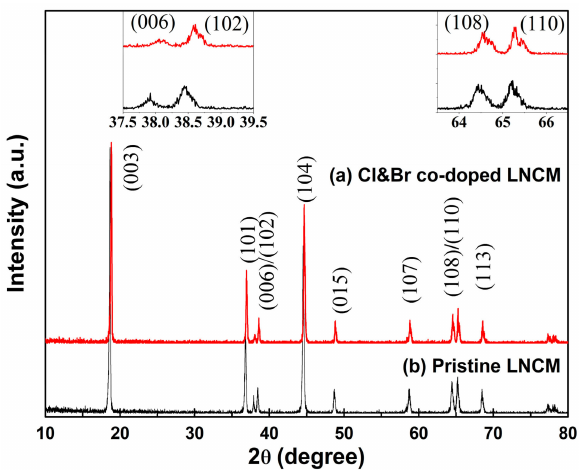
Figure 2. XRD patterns of the synthesized LiNi 1/3 Co 1/3 Mn 1/3 O 2 compounds: ( a ) Cl&Br co-doped LNCM; ( b ) Pristine